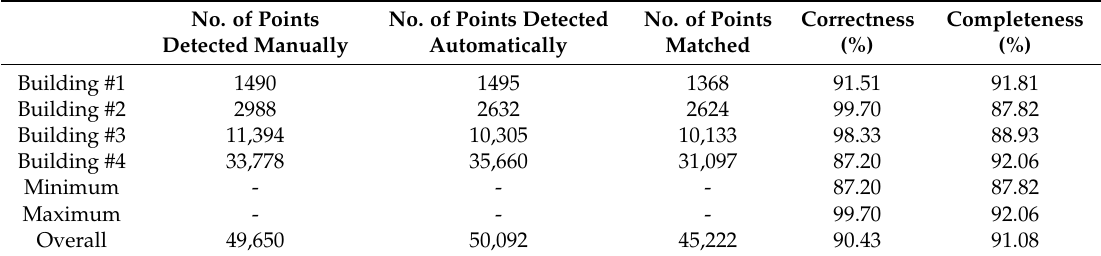
Table 5. Correctness and completeness values of four buildings (Spherical approach).